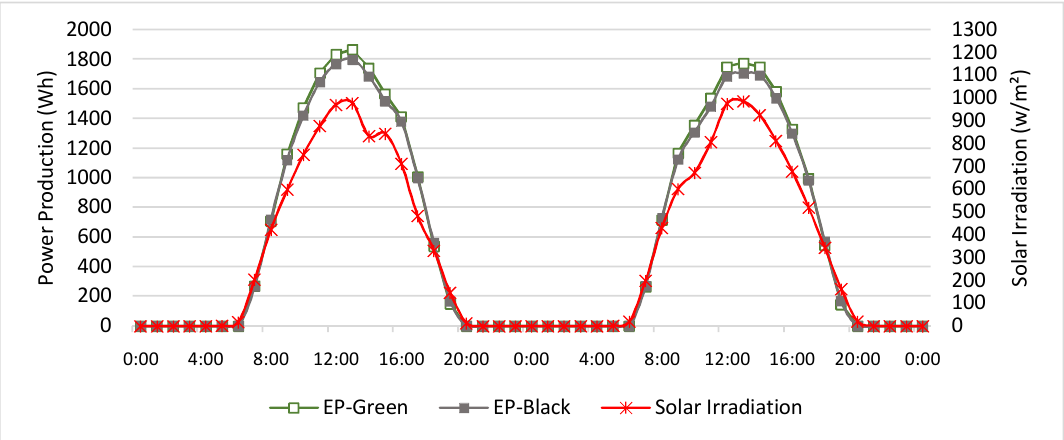
Figure 7. Energy production performance of EP-Green vs. EP-Black (4–5 June).